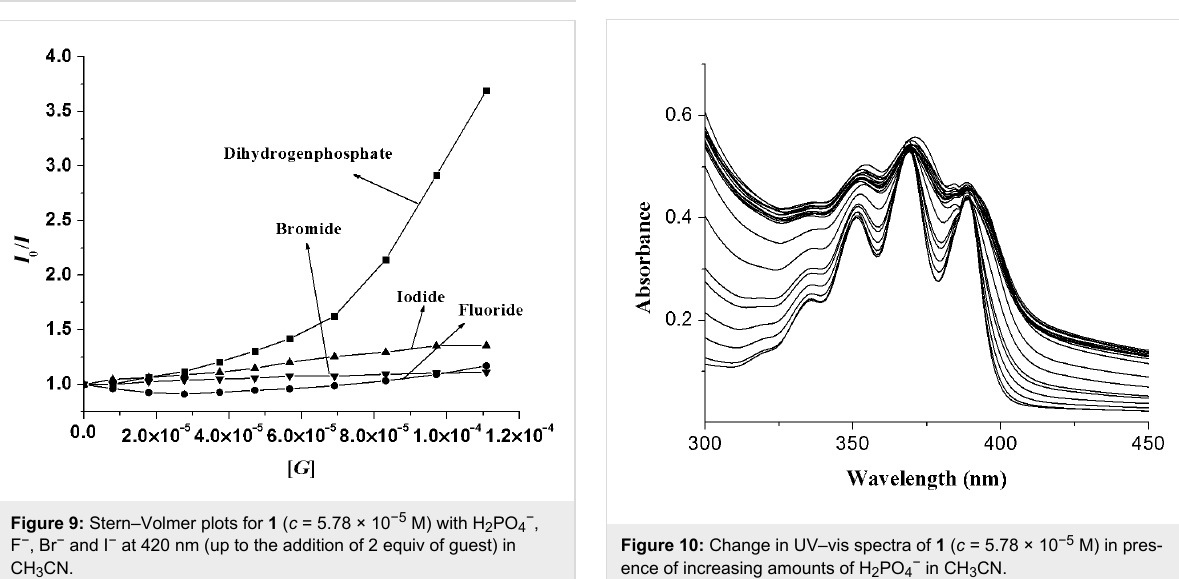
Figure 10: Change in UV–vis spectra of 1 ( c = 5.78 × 10 − 5 M) in pres- ence of increasing amounts of H 2 PO 4 − in CH 3